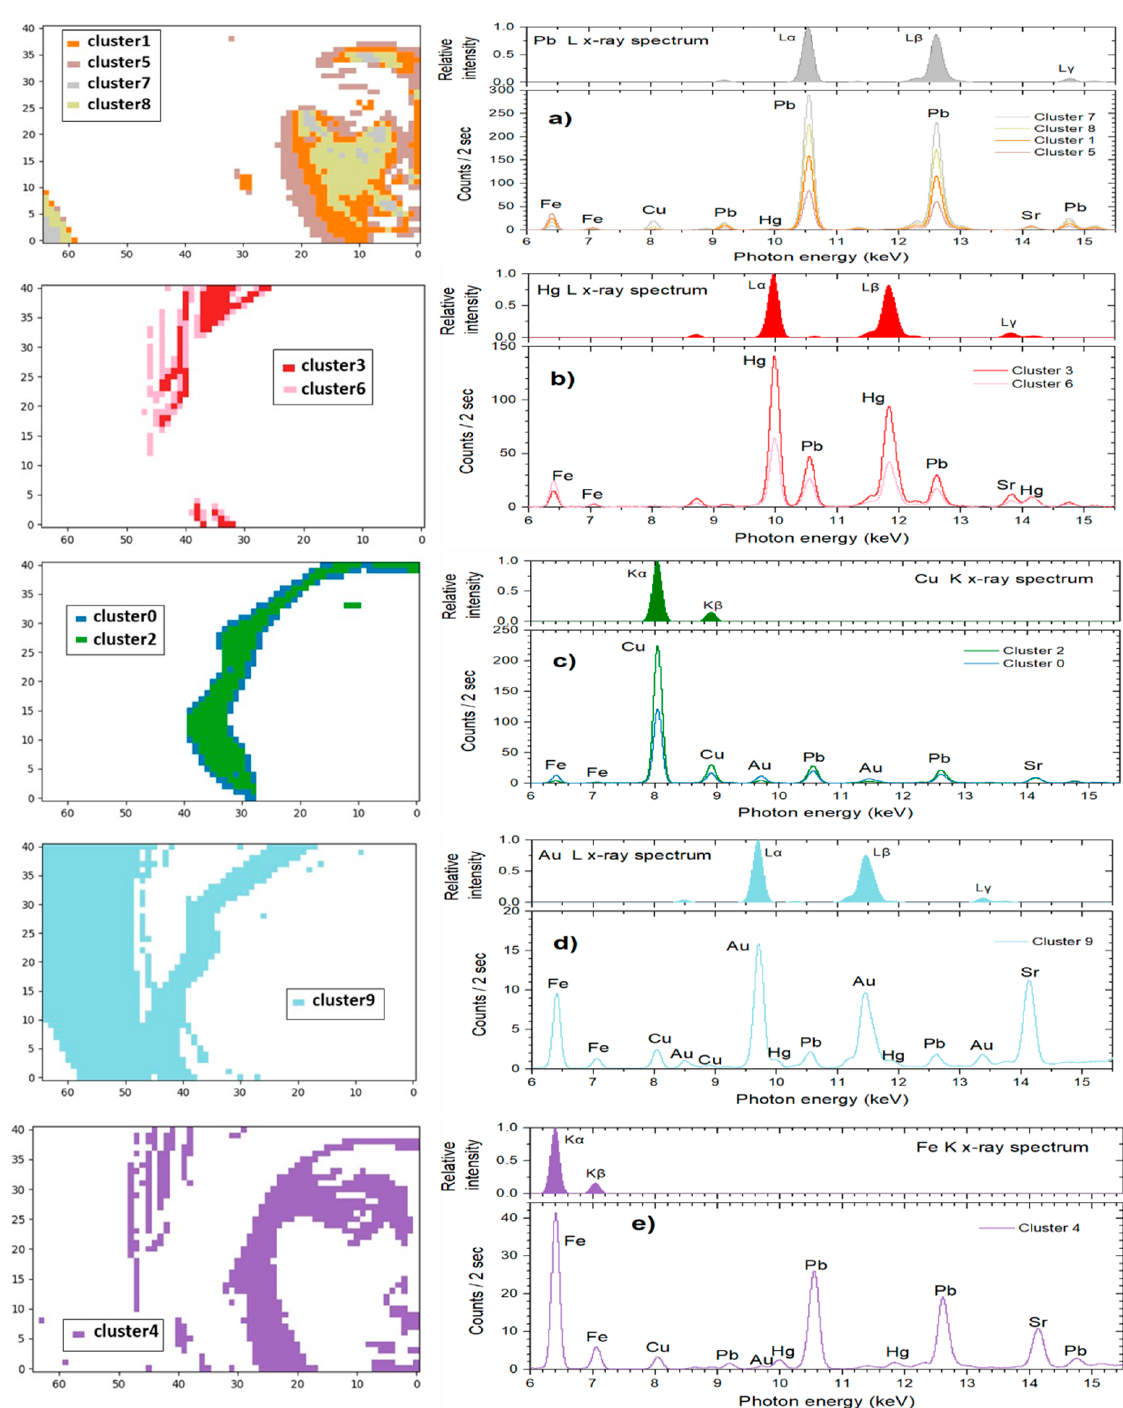
Figure 6. Spatial distribution of clusters ( left ); and corresponding X-ray emission spectra ( right ). On the top of the representative spectra is presented the X-ray spectrum of the dominating element, as evaluated by a Monte-Carlo simulation [44]. ( a ) Clusters 1, 5, 7 and 8. Pb L α is the dominant transition. ( b ) Clusters 3 and 6; dominant transition: Hg L α . ( c ) Clusters 0 and 2; dominant transition: Cu K α . ( d ) Cluster 9; dominant transition: Au L α . ( e ) Cluster 4; dominant transition: Fe K α .